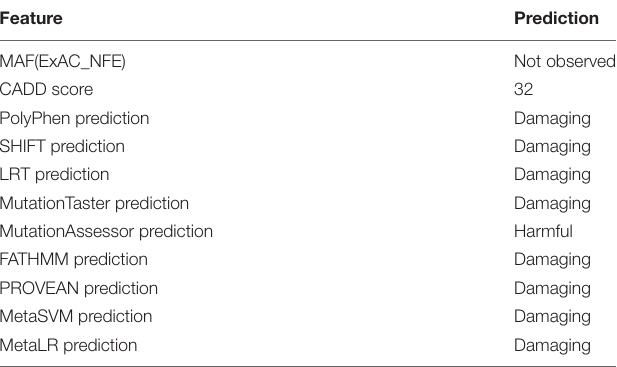
TABLE 2 | Annotations of p.Asp67Val variant in